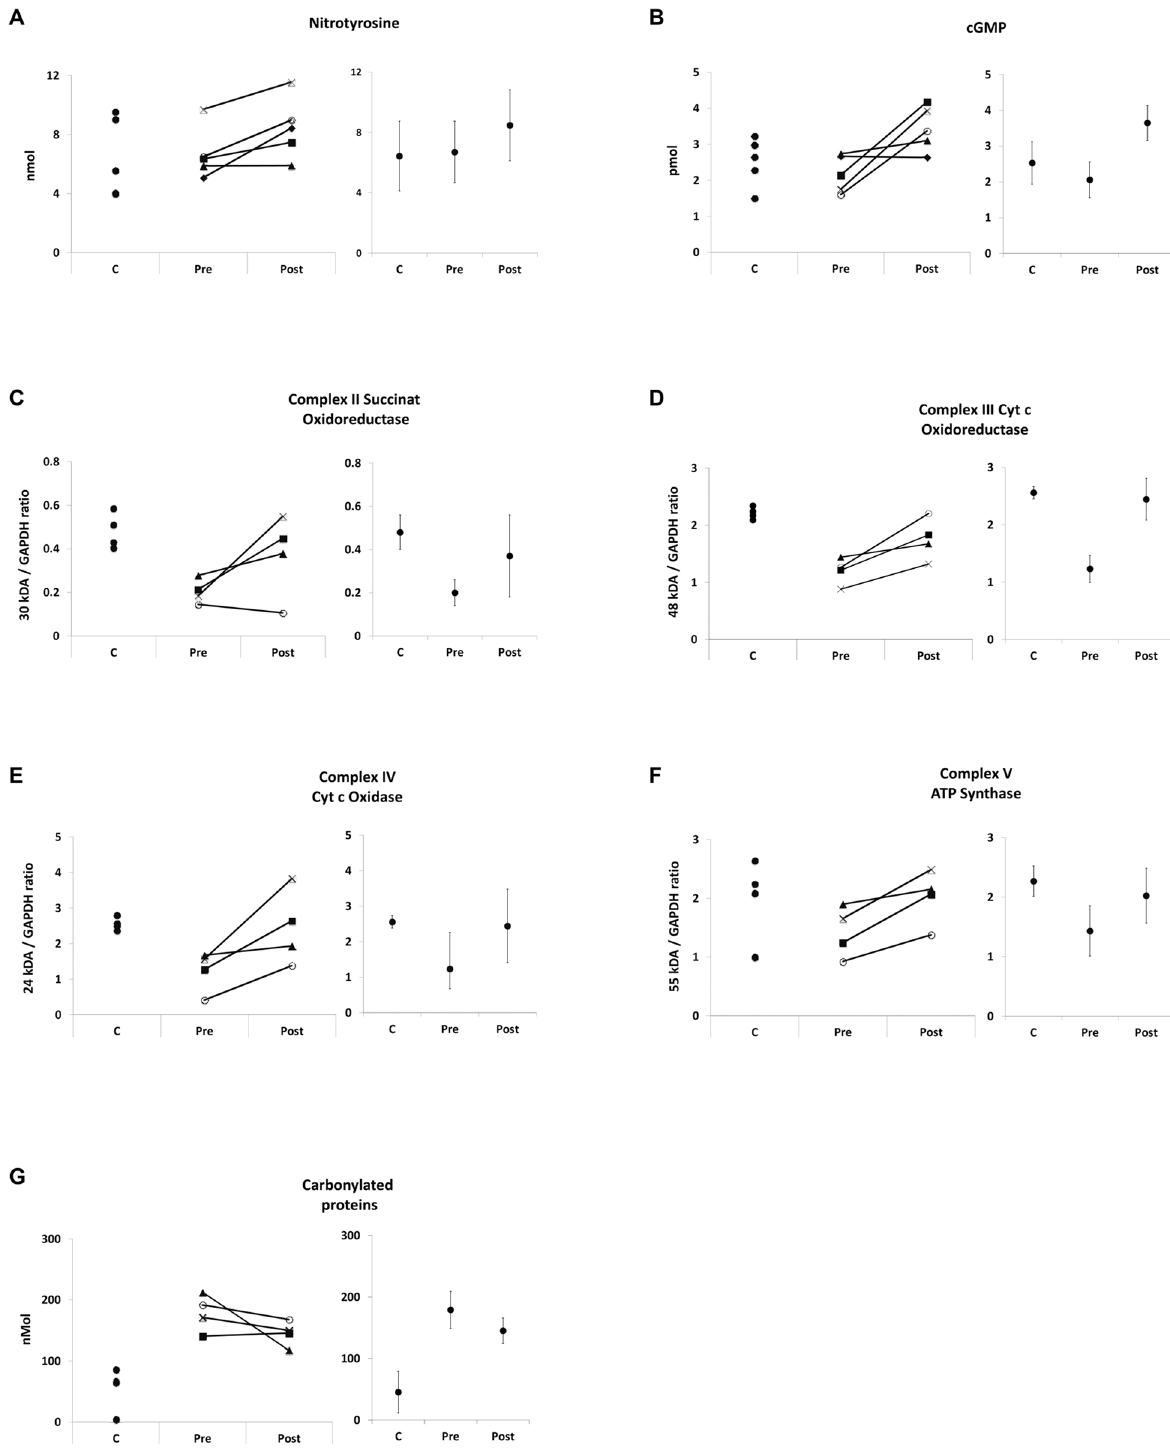
Fig 2. Muscle biopsy. Muscle biopsy findings, individual control (C) concentrations and individual DMD changes before (PRE) and after (POST) treatment as well as point estimates with 95% confidence intervals. A = nitrotyrosine ELISA, concentration is provided in nmol / 7.9 μ g protein, B = cGMP ELISA, concentration is provided in pmol / 6.4 μ g protein, C = western blot succinat oxidoreductase (complex II) / GAPDH ratio, D = western blot cytochrome c oxidoreductase (complex III) / GAPDH ratio, E = western blot cytochrome c oxidase (Complex IV) / GAPDH ratio, F = western blot ATP synthase (Complex V) / GAPDH ratio, G = carbonylated protein ELISA (nmol / 1 μ g protein).